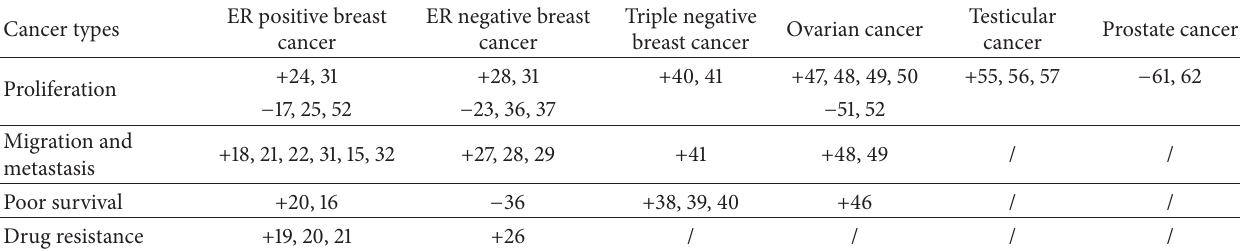
Table 1: The effect of GPER-1 in reproductive system